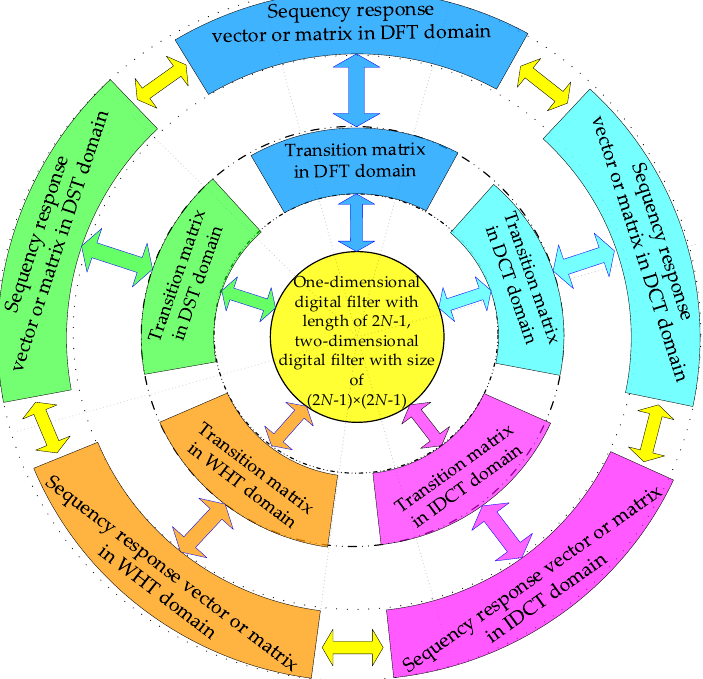
Figure 3. Unity of APDF in different orthogonal transform domains based on DFT, DCT, IDCT, WHT, and DST.